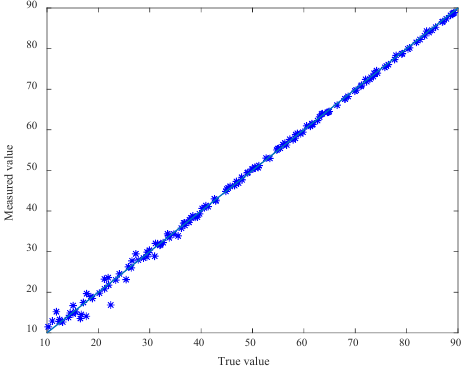
Figure 8. Training results of PSO–SVR model.